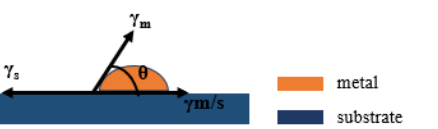
Figure 1. Schematic diagram of surface energy during metal film deposition.